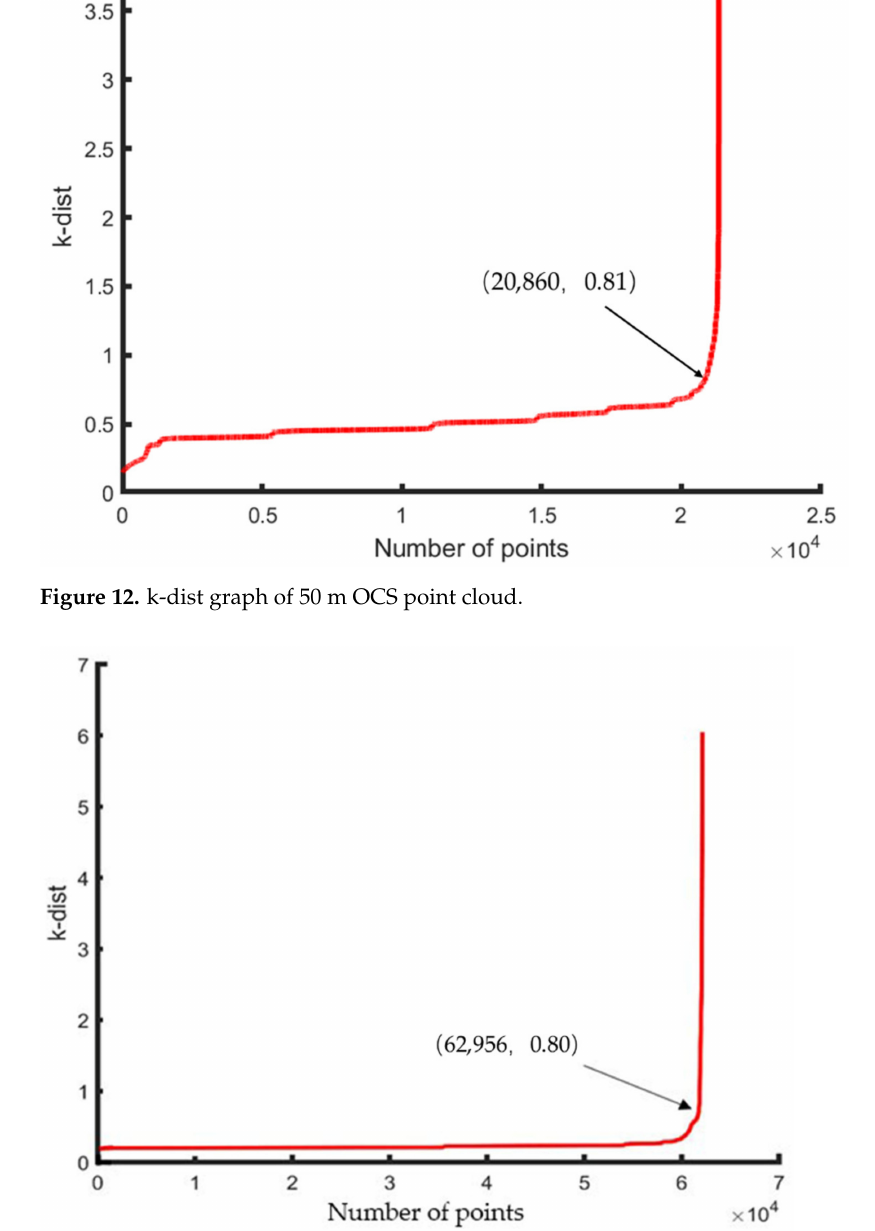
Figure 13. k-dist graph of 100 m OCS point